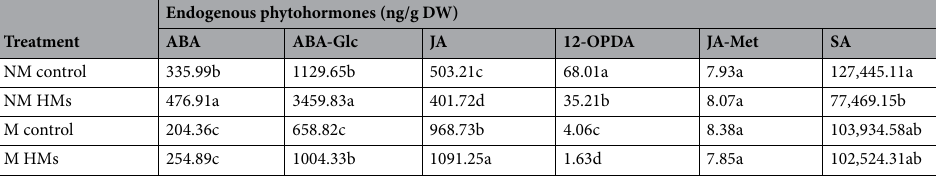
Table 3. Profile of chosen phytohormones in shoots of non-metallicolous (NM) and metallicolous (M) Alyssum montanum cultures growing on both control metal-free and heavy metal enriched (HMs) medium. Different letters indicate statistically significant means according to two-way ANOVA and post hoc Tukey’s test. ABA abscisic acid, ABA-Glc abscisic acid glucosyl ester, JA jasmonic acid, 12-OPDA 12-oxo-phytodienoic acid, JA-Met jasmonic acid methyl ester, SA salicylic